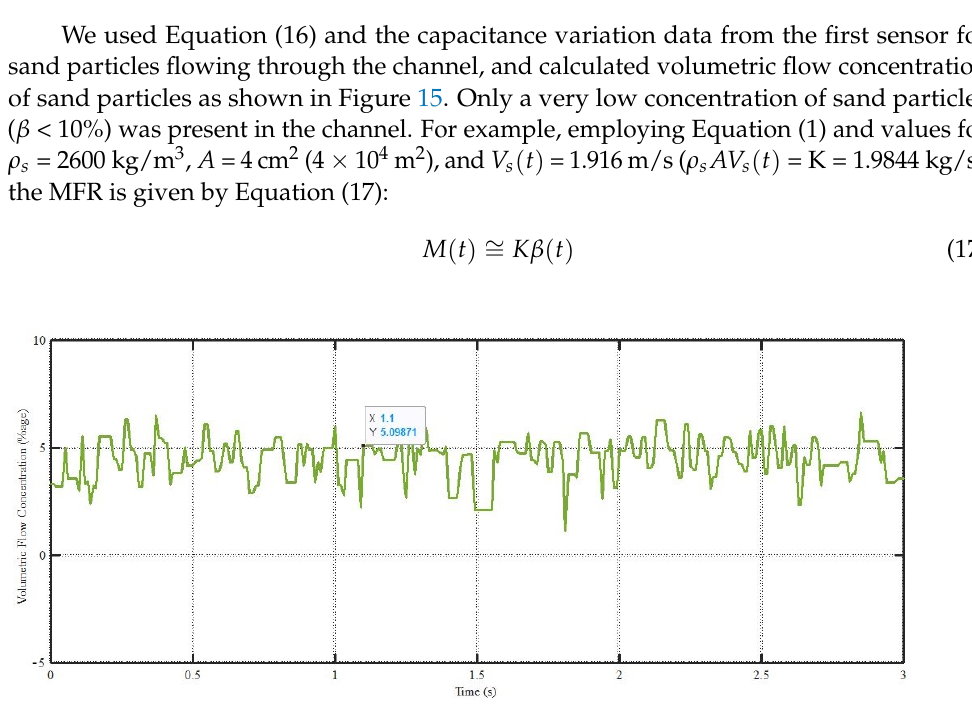
Table 3. Calibration parameters for average capacitance and volumetric concentration. Capacitance (pF)